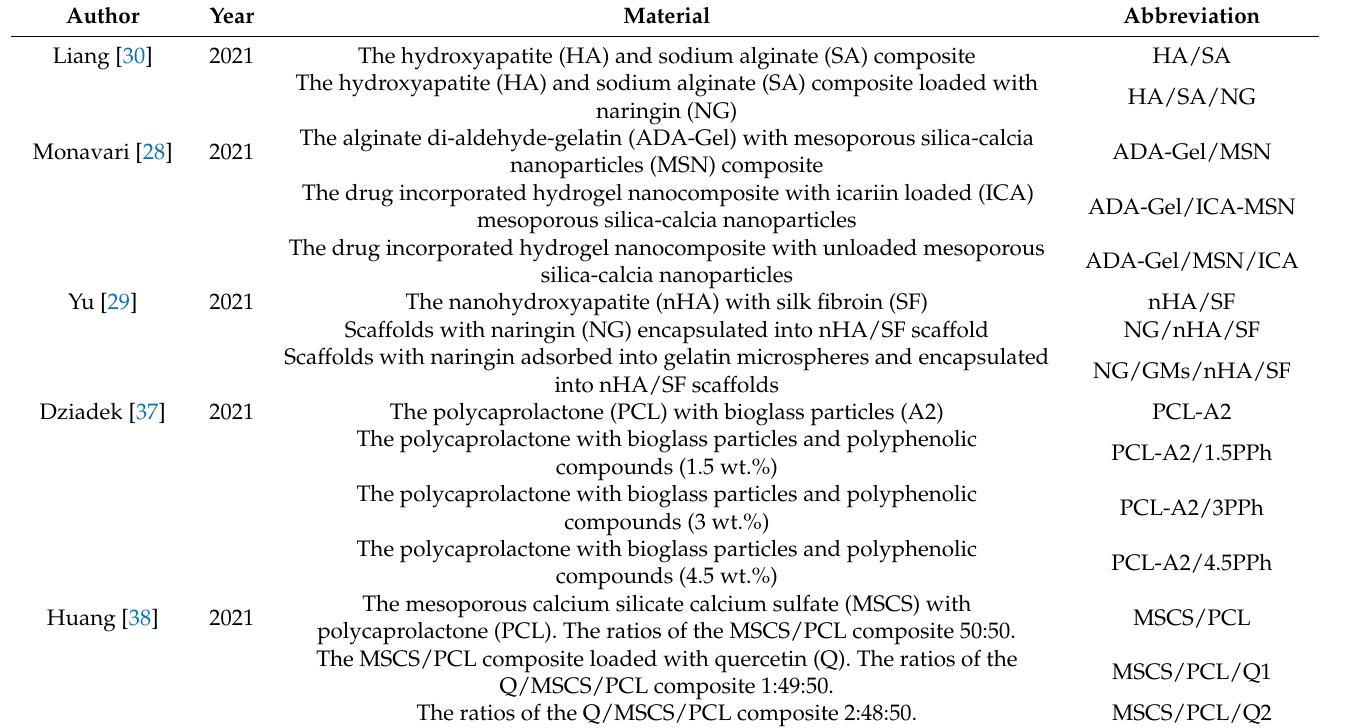
Table A3. List of tested materials in individual